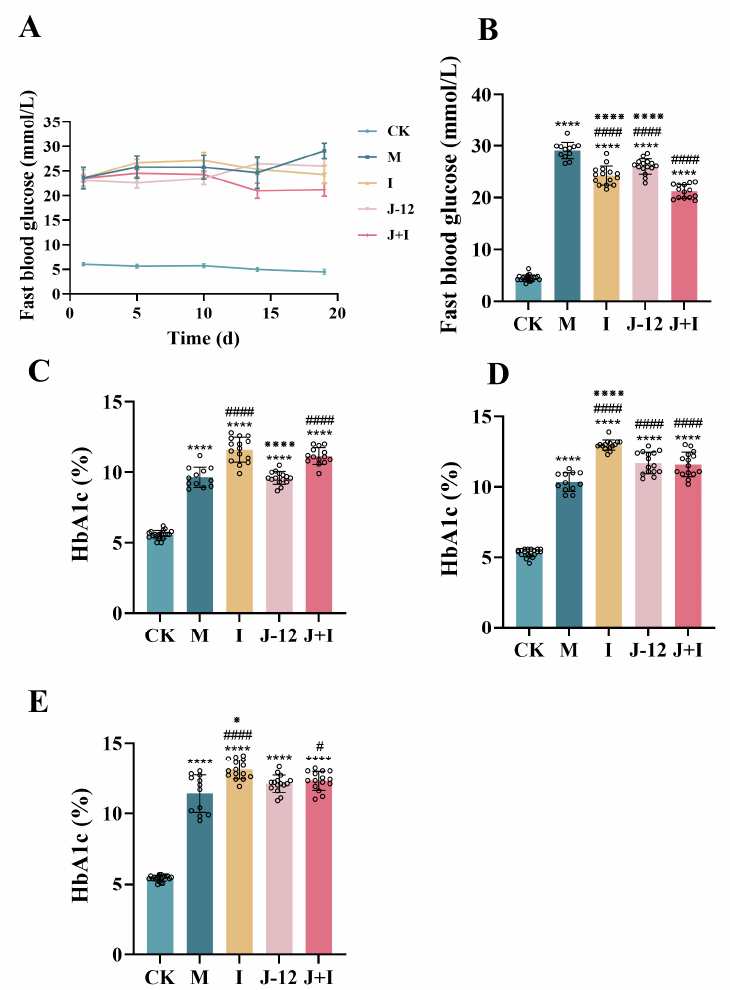
Figure 1. Fasting blood glucose and HbA1c levels during pregnancy in rats. ( A ) Changes in fasting blood during pregnancy. ( B ) Fasting blood glucose in the late of pregnancy (GD 19). ( C ) HbA1c levels in the start of pregnancy (GD 1). ( D ) HbA1c levels in the middle of pregnancy (GD 10). ( E ) HbA1c levels in the late of pregnancy (GD 19). CK: control group, rats fed a standard diet; n = 20. M: model group, rats fed an HFD and administered a single STZ injection prior to pregnancy and then fed a standard diet during pregnancy; n = 12. I: insulin group, rats fed an HFD and administered a single STZ injection prior to pregnancy and then fed a standard diet and injected the insulin and during pregnancy; n = 15. J-12: J-12 group, rats fed an HFD and administered a single STZ injection prior to pregnancy and then fed a standard diet during pregnancy. Rats administered the J-12 suspension (1 × 10 9 CFU daily) by gavage during the entire experimental period; n = 15. J + I: J-12 plus insulin group, rats fed an HFD and administered a single STZ injection prior to pregnancy and then fed a standard diet and injected with insulin during pregnancy. Rats administered the J-12 suspension (1 × 10 9 CFU daily) by gavage during the entire experimental period; n = 14. Statistical analyses were performed by using a one-way ANOVA with Tukey’s multiple comparison test. Data are presented as the means ± SD; **** p < 0.0001, compared with the CK group; # p < 0.05 and #### p < 0.0001, compared with the M group; ※ p < 0.05 and ※※※※ p < 0.0001, compared with the J + I group.